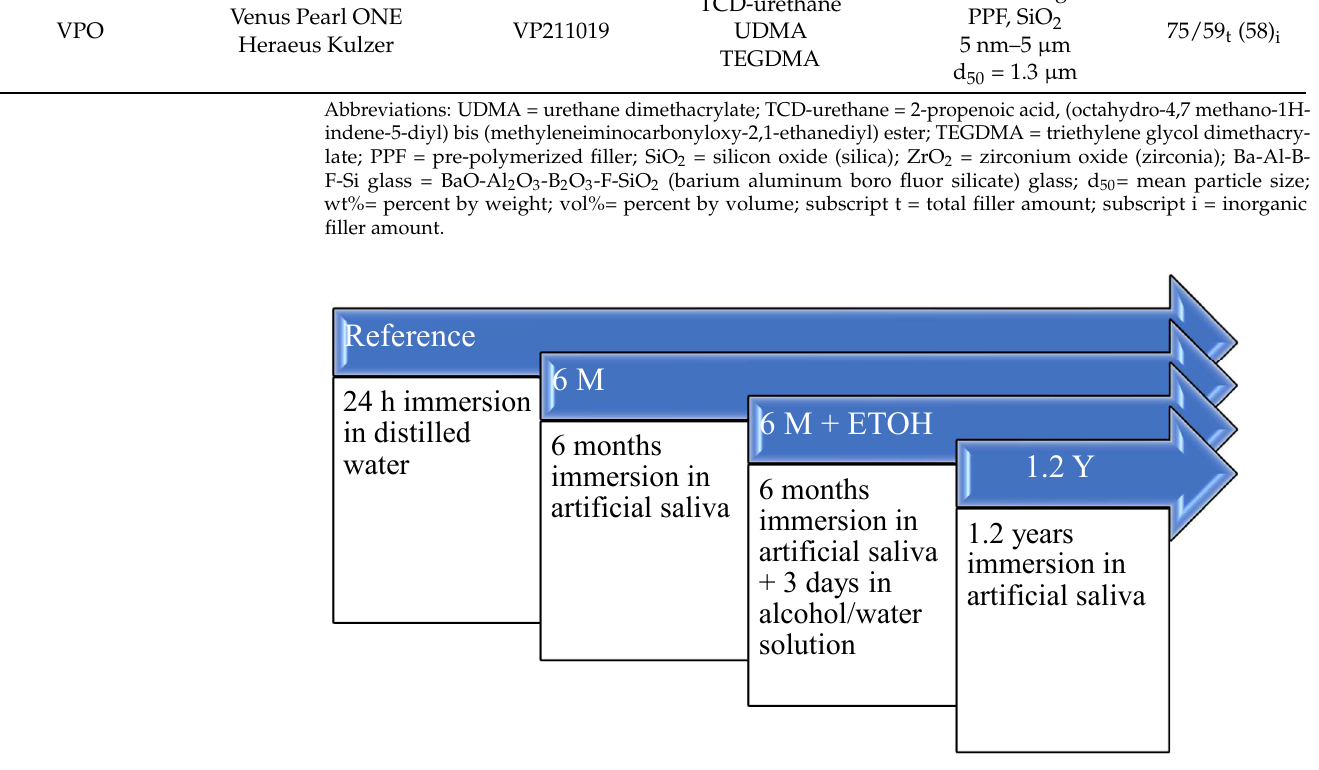
Figure 1. Overview of the four aging methods.